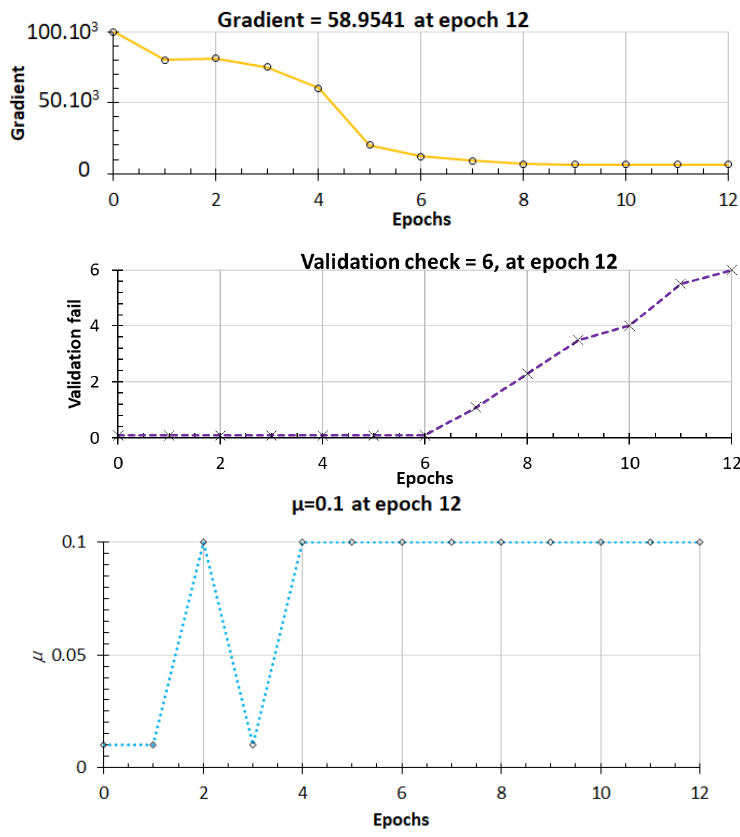
Figure 8. Plot of model performance evolution regarding the number of epochs.